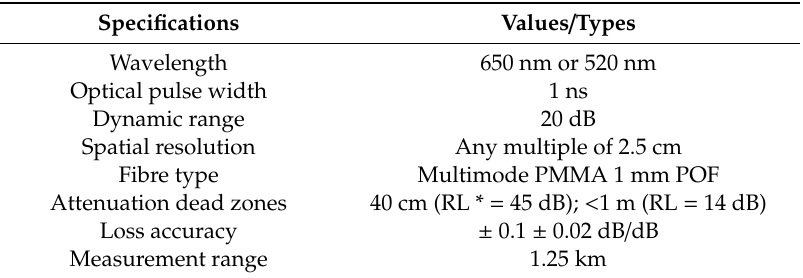
Table 1. Specifications of the ν -OTDRs [34] adopted in this